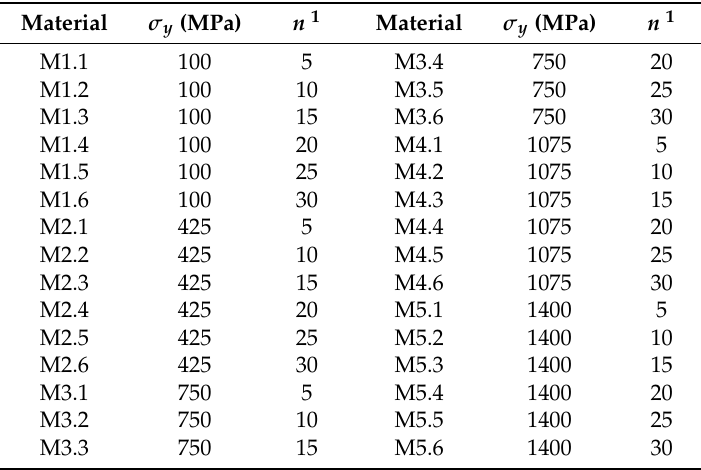
Table 1. Plastic properties of the hypothetical materials.